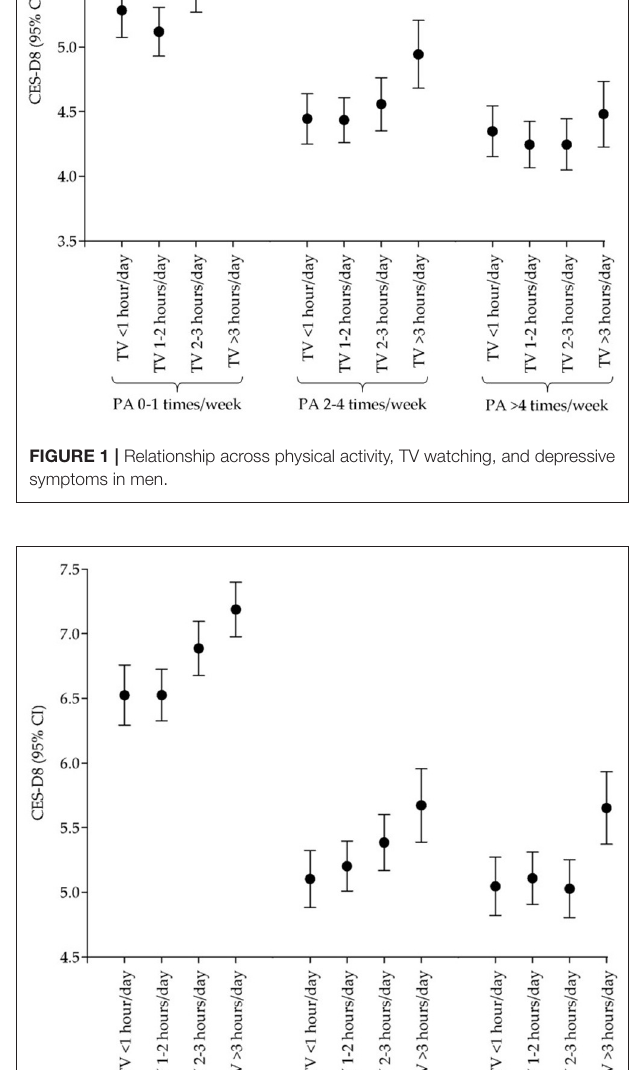
models among individuals who spent > 3 h/day watching TV. These results support the hypothesis that spending a greater amount of time TV watching is associated with increased depressive symptoms, providing further evidence on the detrimental effect of SB on mental health (14). Despite the uncertain mechanisms associating SB such as TV watching